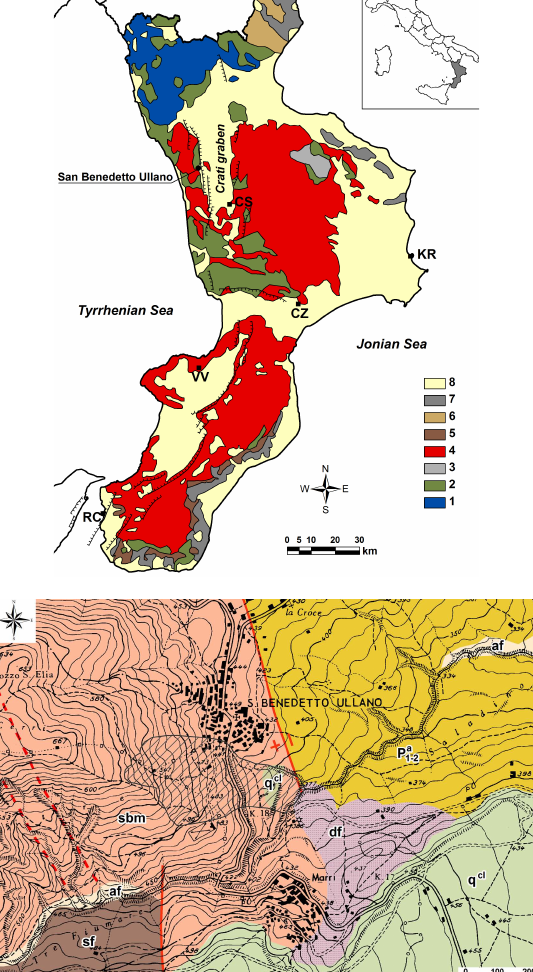
Fig. 1. (a) Location of the study area and main lithological com- plexes of Calabria (after Sorriso-Valvo, 1993, mod.). Key: (1) car- bonate units; (2) very low to low-grade metamorphic units, at places with ophiolites; (3) sedimentary, flysch-type sequence; (4) inter- mediate to high-grade metamorphic and intrusive rocks; (5) tur- biditic, mainly coarse-grained deposits; (6) flysch-type nappes, mainly marley-clayey; (7) flysch-type nappes, with chaotic struc- ture; (8) sedimentary autochthonous units; CS) Cosenza; CZ) Catanzaro; KR) Crotone; RC) Reggio di Calabria; VV) Vibo Valentia. In black, the main tectonic structures belonging to the Calabrian-Sicilian Rift Zone (after Monaco and Tortorici, 2000, mod.) are also shown. (b) Geological map of the study area, after CASMEZ (1967), modified. Key: (af) alluvial sediments (Holocene); (df) landslide debris (Holocene); (q cl ) loose conglom- ) grey-blue erate of ancient fluvial terraces (Pleistocene); (P a 1 − 2 silty clay (Middle-Late Pliocene); (sbm) gneiss and biotitic schist with garnet, locally including abundant granite and pegmatite veins, forming migmatite zones (Palaeozoic); (sf) grey phyllitic schist, with rare intercalations of limestone and arenite, and quartz veins (Palaeozoic). The area shaded in black delimits the sector threat- ened by the San Rocco landslide. In the figure, the road to the cemetery, the church of S. Rocco, and the provincial road to Marri (SP.31) are also